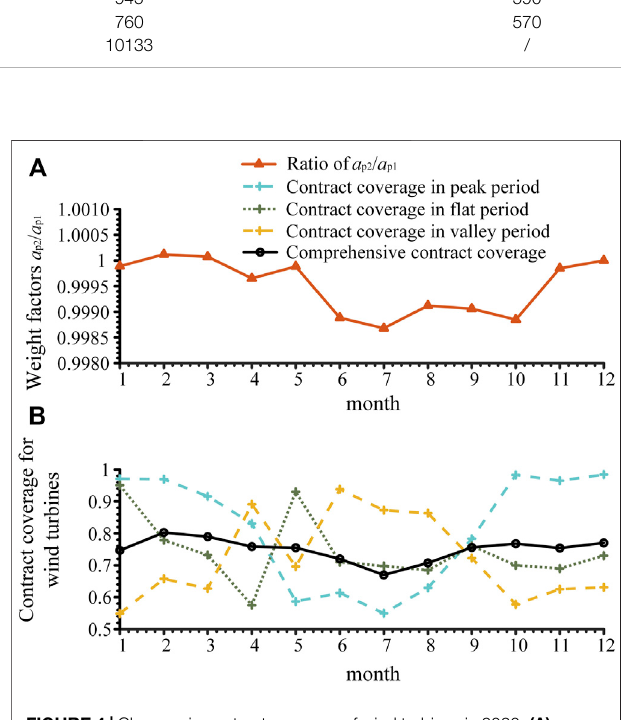
Frontiers in Energy Research |